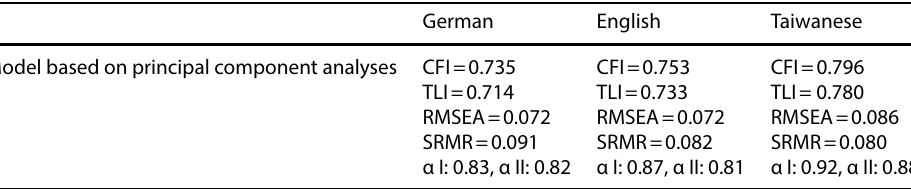
Table 2 Fit values (derived from confirmatory factorial analyses) and internal consistency estimates (Cronbach’s alphas) of the newly proposed